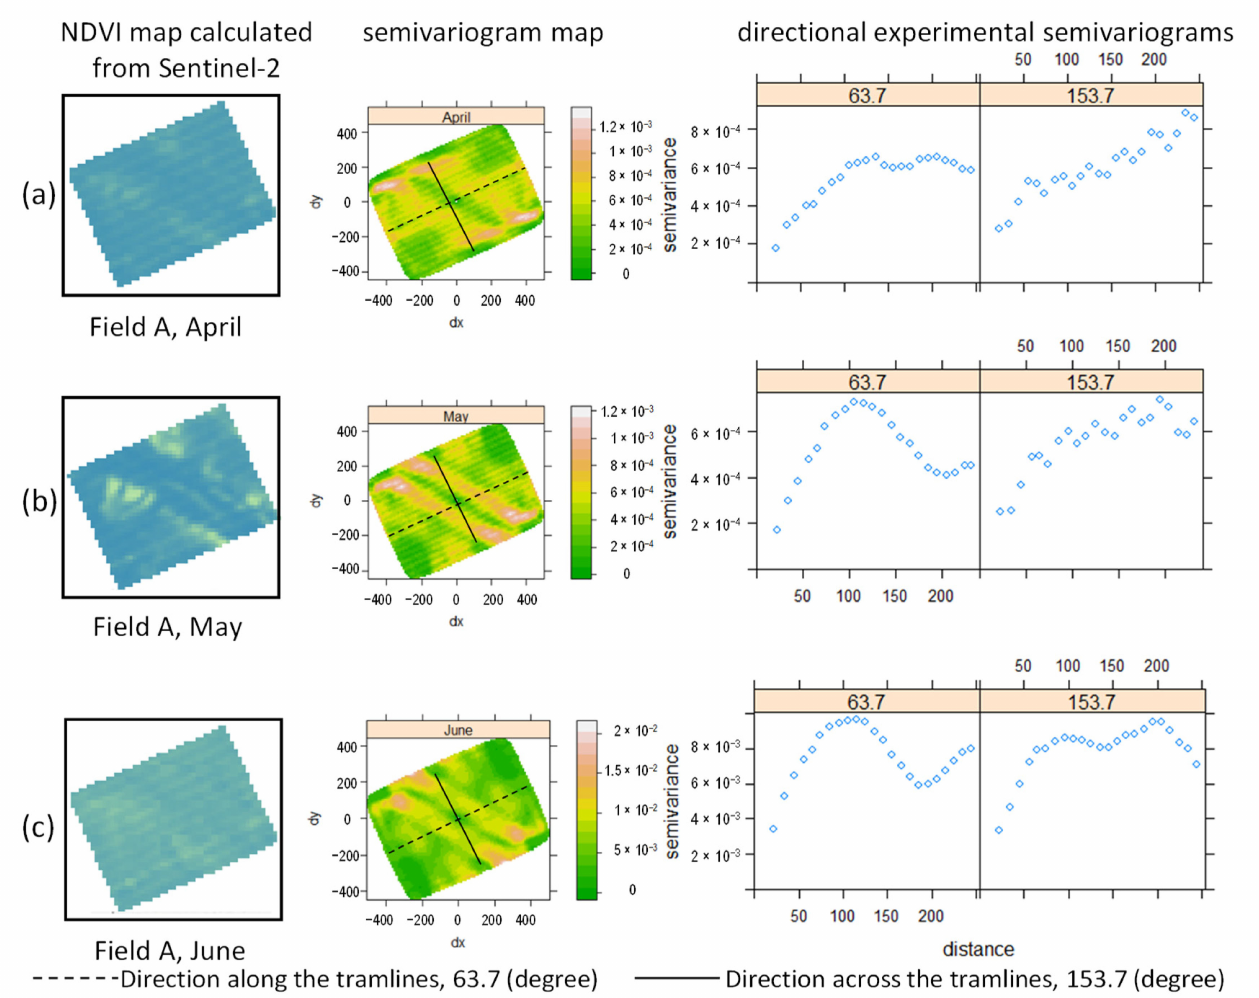
Figure 9. Relationship between the semivariogram map and experimental semivariograms calculated along and across the tramline direction for ( a ) April, ( b ) May, and ( c ) June for field A. From left to right, it shows the NDVI image, the semivariogram map calculated from Sentinel-2 NDVI and profiles of directional experimental semivariograms along and across the tramlines. The dashed and continuous line in the semivariogram maps indicate the direction of the along and across tramline directional